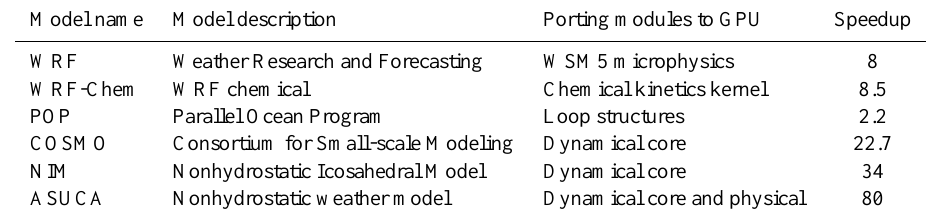
Table 1. Existing GPU porting work in climate fields. The speedups are normalized to one CPU